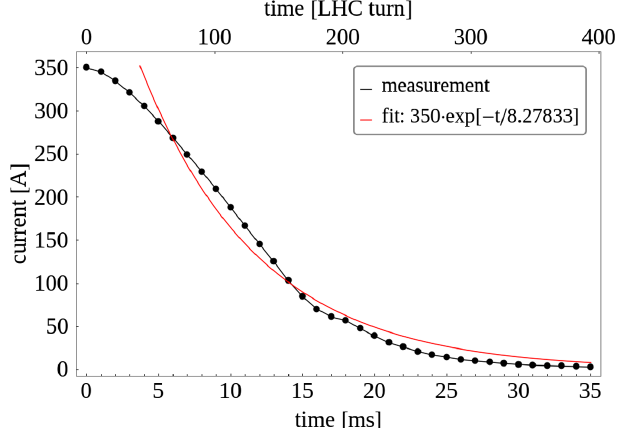
FIG. 19. Measured current decay following an electrical short in the power supply to be used for the BBCW, including an exponential fit neglecting the initial